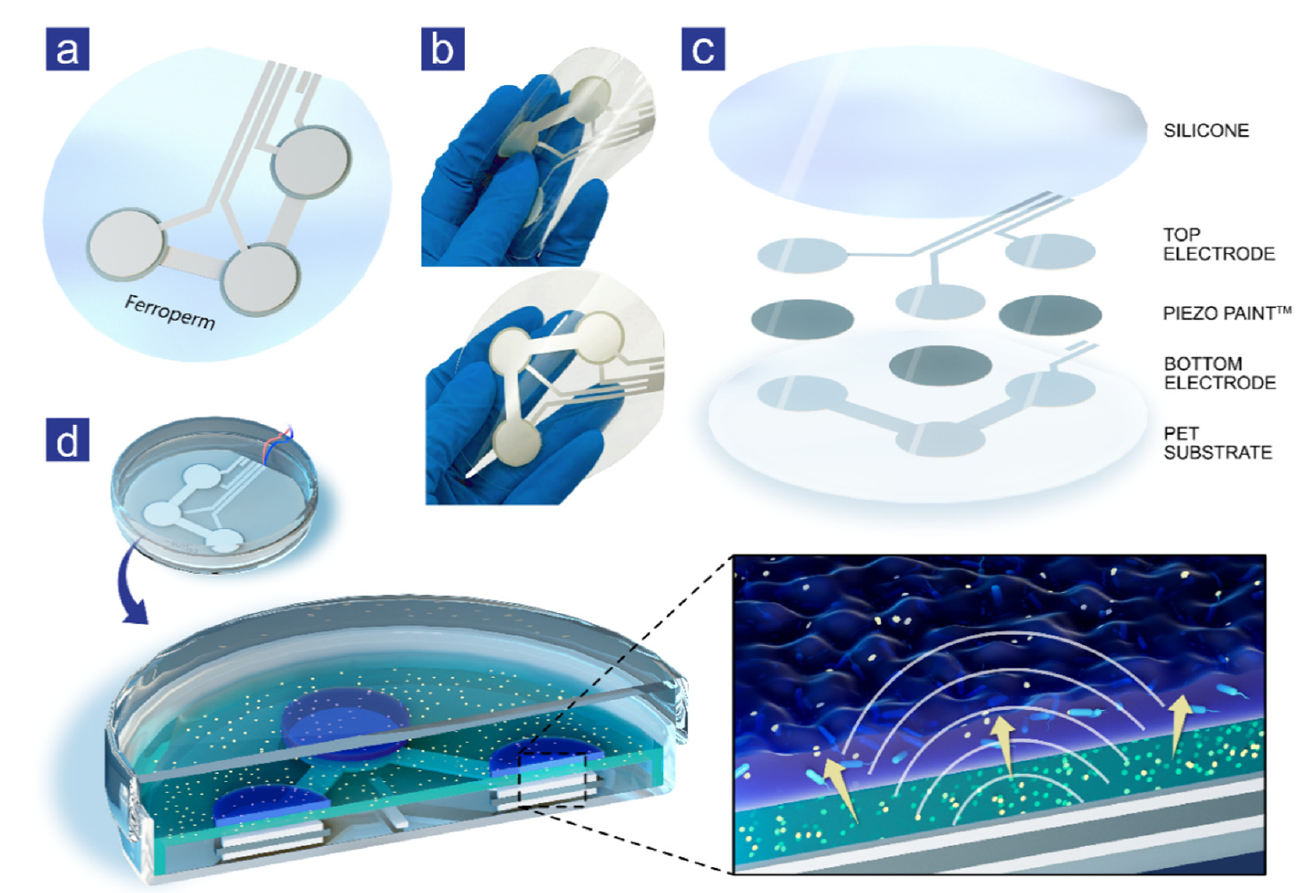
Figure 1. Ferroperm PiezoPaint™ patch. ( a ) Illustration presenting a three-element transducer screen-printed on a flexible PET substrate. ( b ) Photos of a flexible piezoelectric patch. ( c ) Expanded view exhibiting all layers of the ultrasound patch where the bottom silver electrode was screen-printed directly on a PET substrate, followed by deposition of PiezoPaint™ and silver top electrode. The sandwiched structure was protected with a silicone layer. ( d ) Image illustrating PiezoPaint™ patch in a Petri dish, covered with agar mixed with antibiotics on which 24-hour-old filter-biofilms were placed. The magnification represents the ultrasound waves generated by the PiezoPaint™ patch, which contribute to increased cell membranes' permeability and transport of antibiotics.